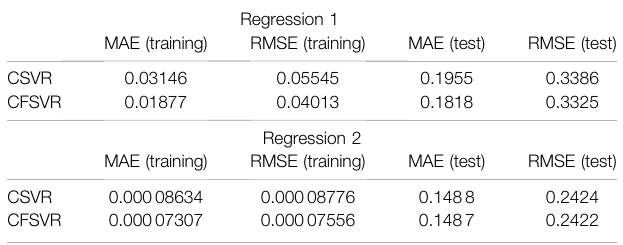
TABLE 2 | Performance of CFSVR and CSVR on non-linear regression.